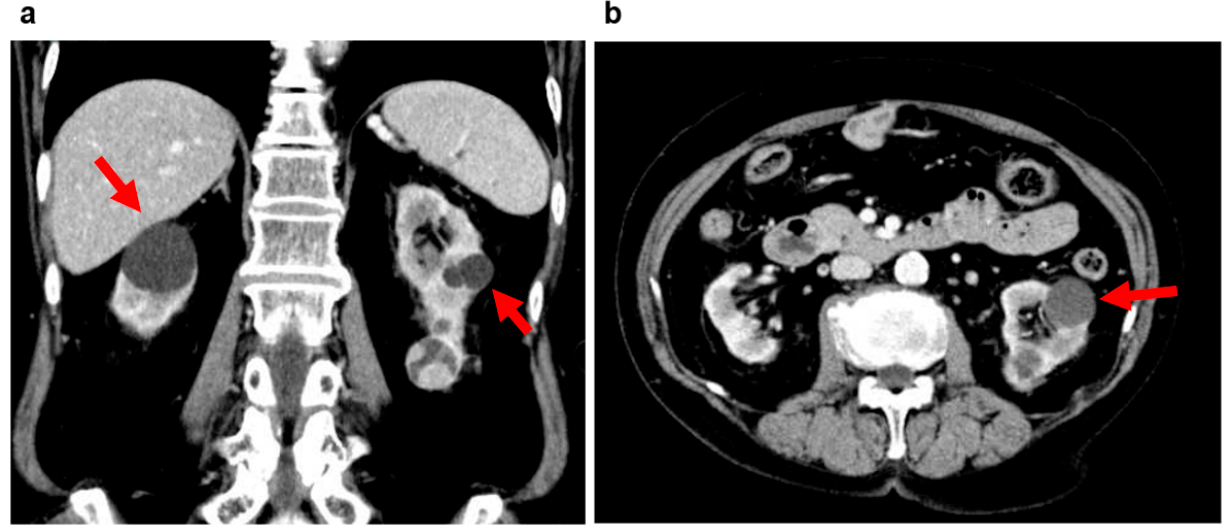
Figure 2. Acquired cystic kidney disease (ACKD): 70s, female, history of hemodialysis 3 years (primary disease: diabetic nephropathy), Bosniak class IV (image provided by Osaka Saiseikai Nakatsu Hospital). ( a ) Contrast CT image (coronal section): Several low-density cysts (arrow) in both kidneys and a densely stained solid area of cystic lesions is visible on the inferior pole of the left kidney. ( b ) Contrast CT image (horizontal section): Several low-density cysts (arrow) in both kidneys and a densely stained solid area of cystic lesions is visible on the inferior pole of the left kidney. Additionally, ACKD cysts are known to shrink in size following kidney transplant